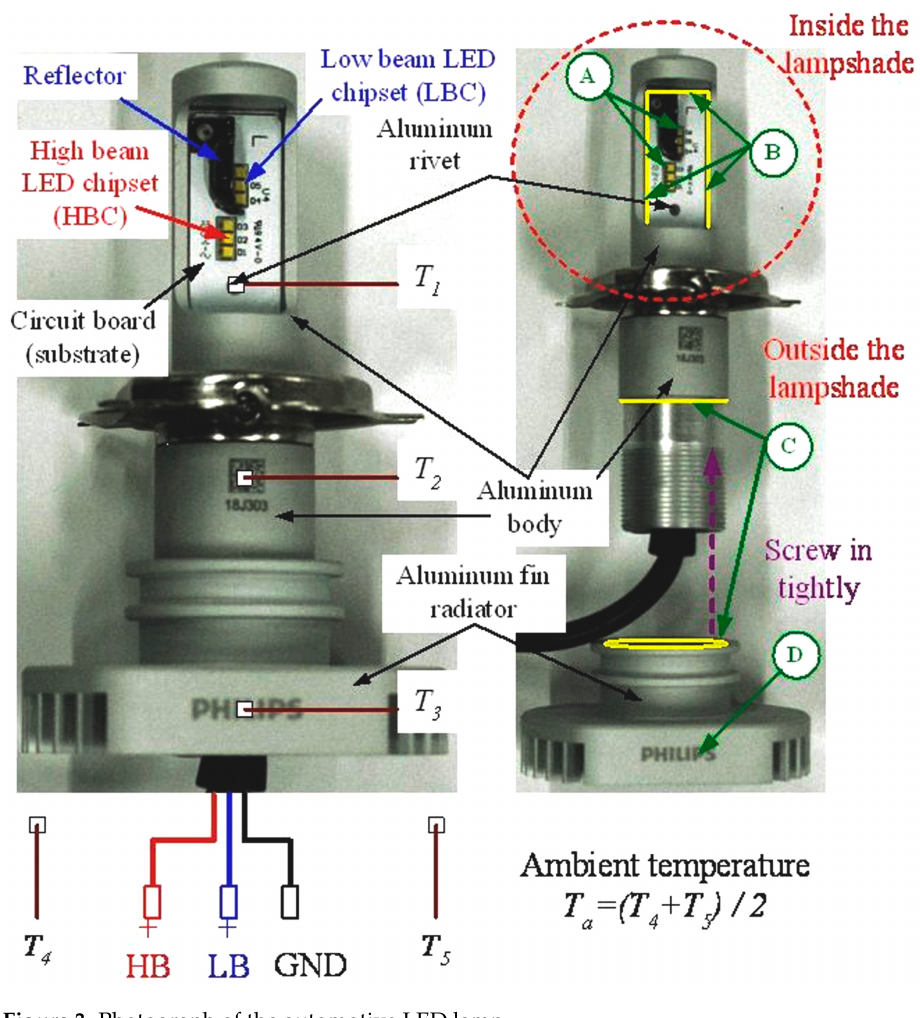
Figure 3. Photograph of the automotive LED lamp.